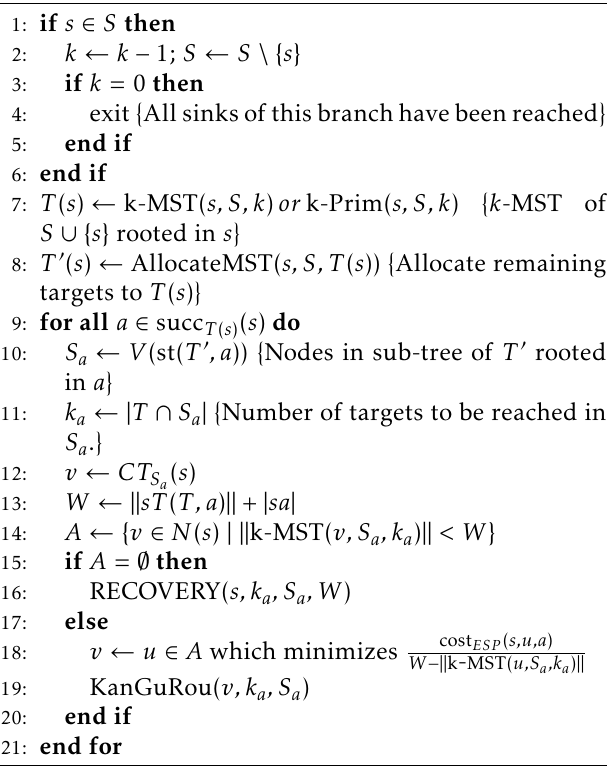
Algorithm 1 KanGuRou( s; k; S ) – Run at node s to reach k targets in S